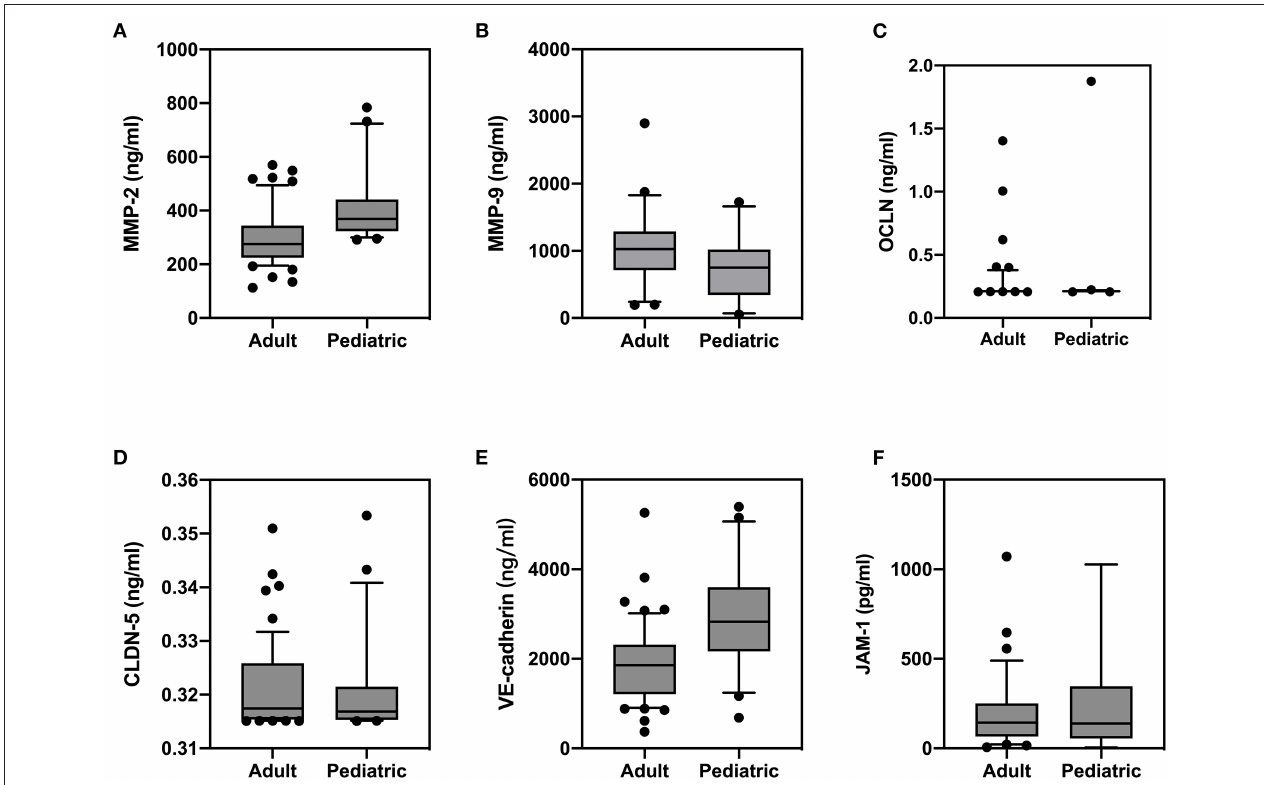
FIGURE 1 | Comparison of serum levels of matrix metalloproteinase (MMP)-2 (A) , MMP-9 (B) , occludin (OCLN) (C) , claudin-5 (CLDN5) (D) , vascular endothelial (VE)-cadherin (E) , and junction-associated molecule (JAM)-1 (F) between adult and pediatric patients with and without spontaneous hemorrhages.